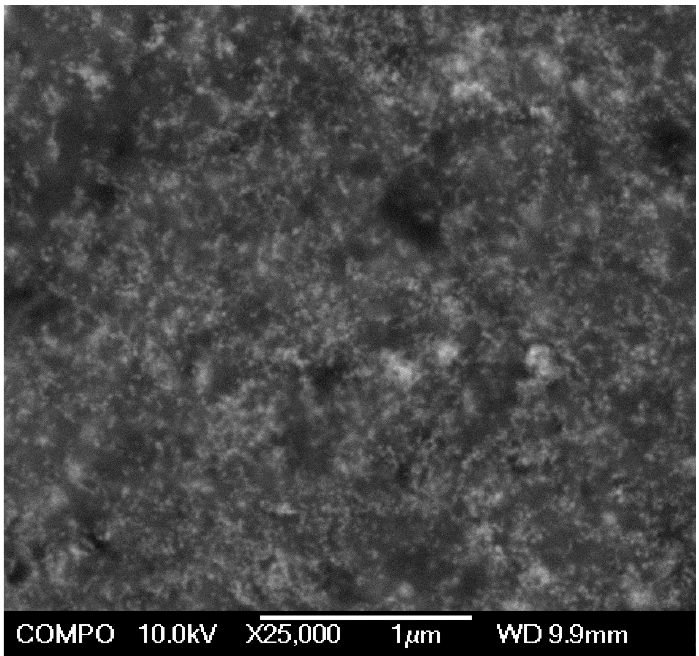
Figure 8. SEM image of dried FG1 sample (7.7 wt. % of MNPs in dried state, 0.63 wt. % in swollen state) covered with 20 nm conductive carbon layer in order to enhance conductivity. Brighter agglomerates remind the aggregations of MNPs.